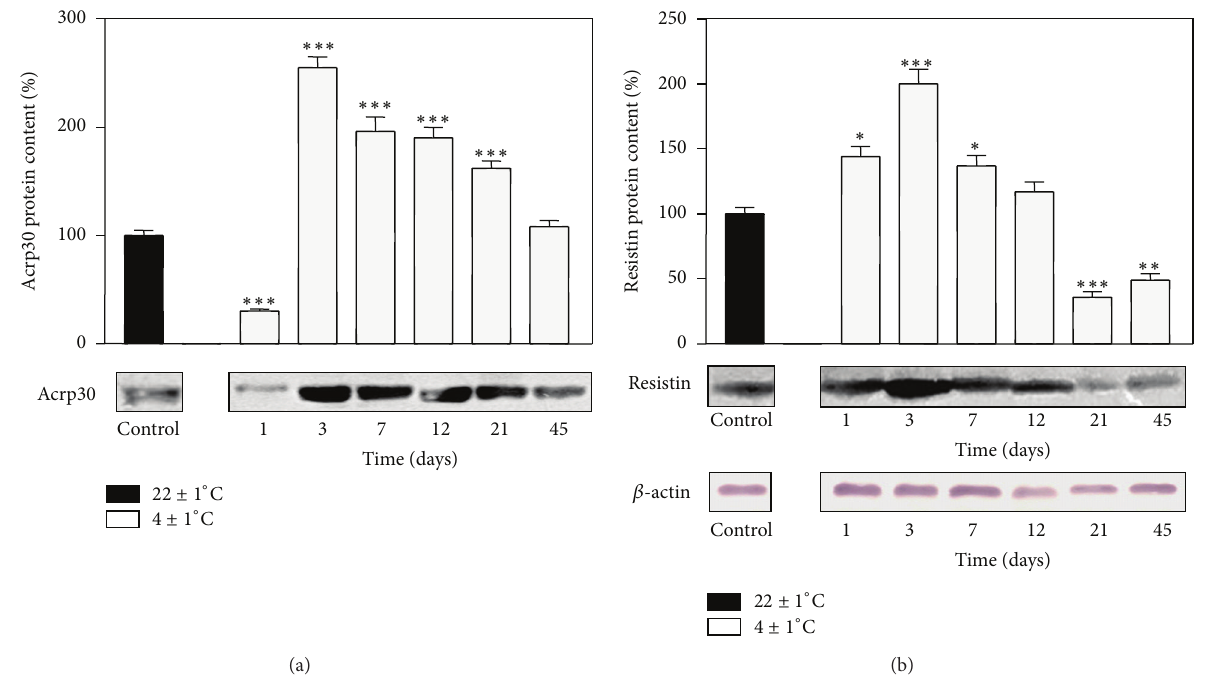
Figure 1: Time course of the changes in protein expression of adiponectin (Acrp30) (a) and resistin (b) in rat RpWAT during cold acclimation. Protein content is expressed relative to a control acclimated to room temperature, which was standardized as 100%. The results of the representative example from three observations are shown. Data were quantified as described in Section 2. The values represent the mean